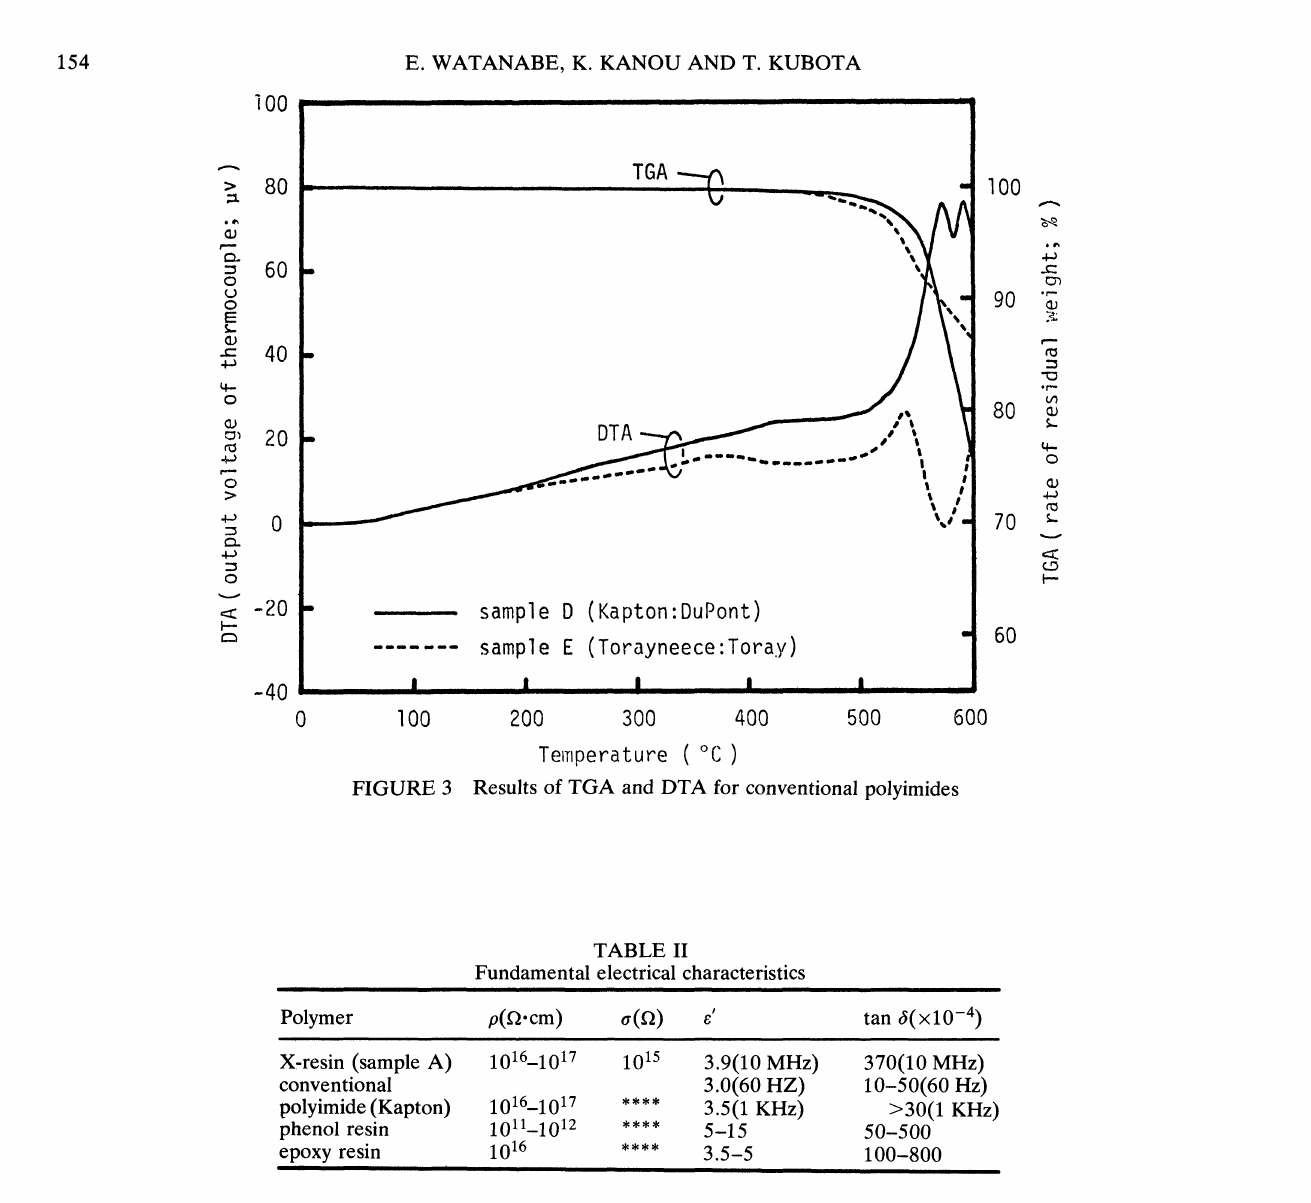
TABLE III Results of damp-heat tests for electrical